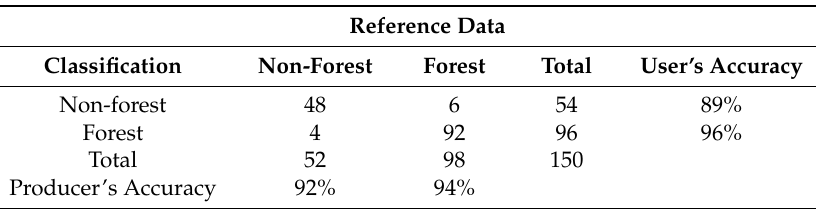
Table 3. Confusion matrix for the forest classification